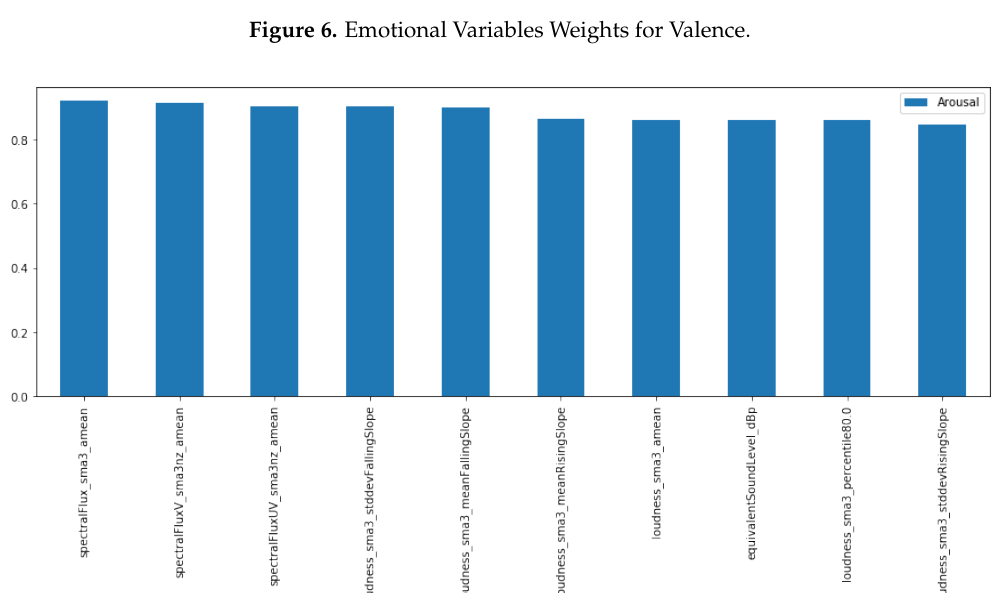
Figure 7. Emotional Variables Weights for